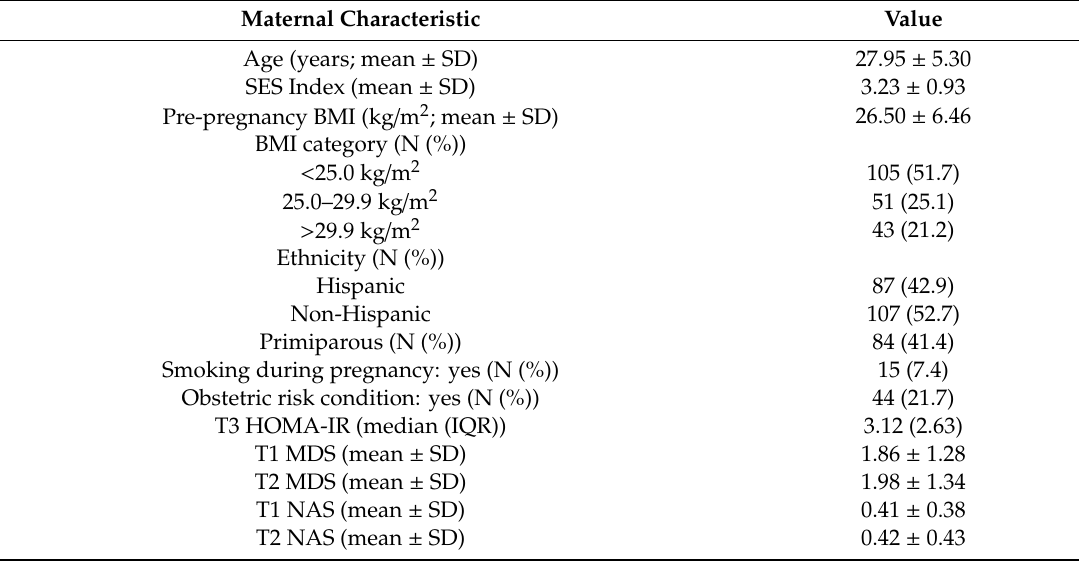
Table 1. Maternal sociodemographics, insulin resistance, the Mediterranean Diet Score (MDS) and negative a ff ect score (NAS) ( N = 203).